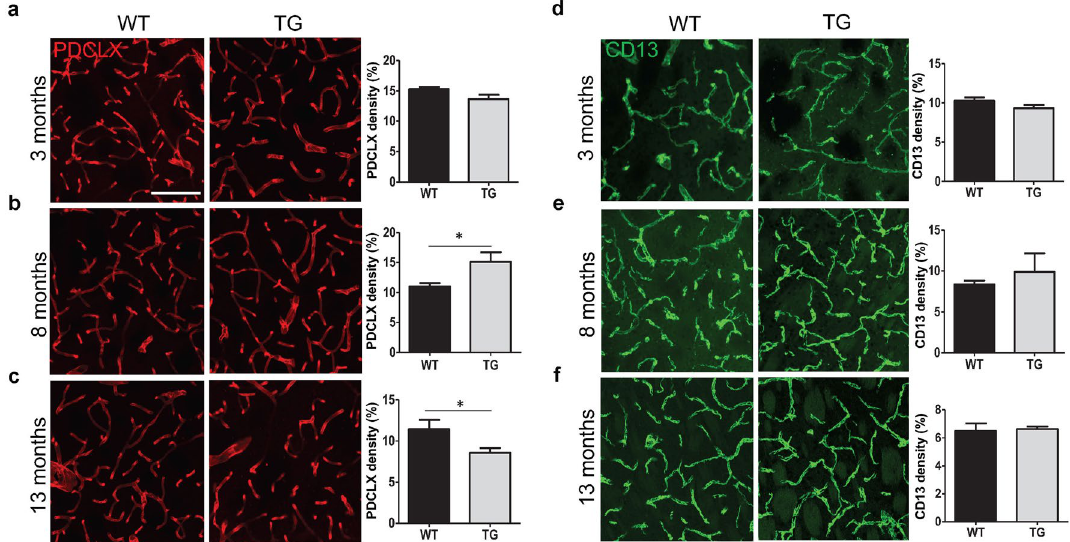
Figure 5. Alterations in striatal vessel and pericyte density in TG mice. ( a–c ) Confocal images illustrating PDCLX + vessel density in WT and TG mice and quantification at ( a ) age of 3 months (n = 6 WT, 9 TG); ( b ) age of 8 months (n = 4 WT, 4 TG); and ( c ) age of 13 months (n = 7 WT, 8 TG). ( d–f ) Confocal images showing CD13 + pericyte density in WT and TG mice and quantification ( d ) at age of 3 months (n = 4 WT, 6 TG); ( e ) at age of 8 months (n = 4 WT, 4 TG); and ( f ) at age of 13 months (n = 7 WT, 5 TG). Two-tailed student’s t-test: *p-value < 0.05. Scale bar: 100 μm.